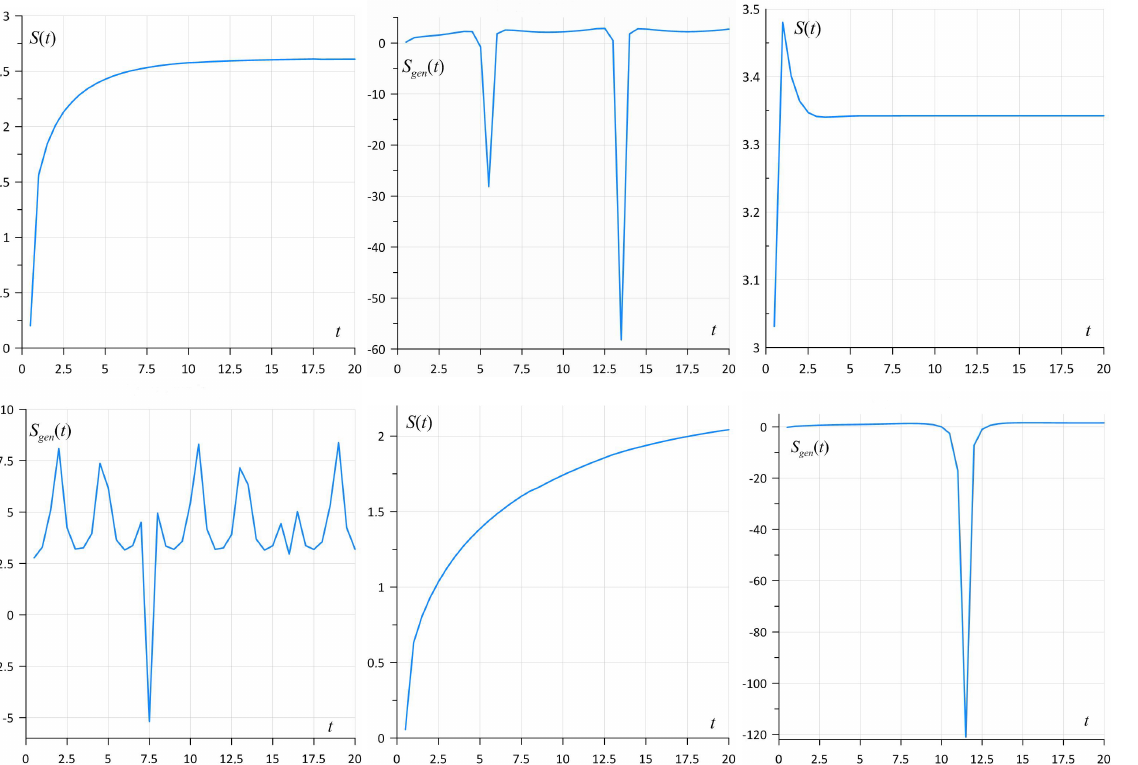
Figure 12. In the figure, the left column of three graphs describes the Shannon entropy for three different environmental states, while the right column describes the generalized entropy describing the JS for the same environmental